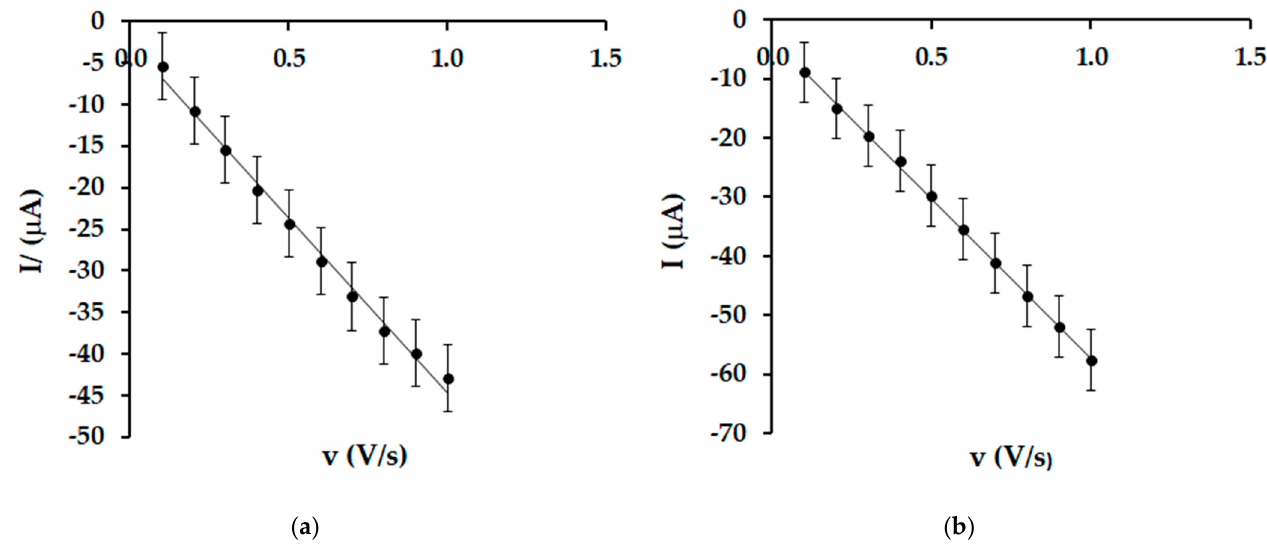
Figure 6. Linear dependence between cathodic current and scanning rate for SPE/SWCNT/Lac ( a )